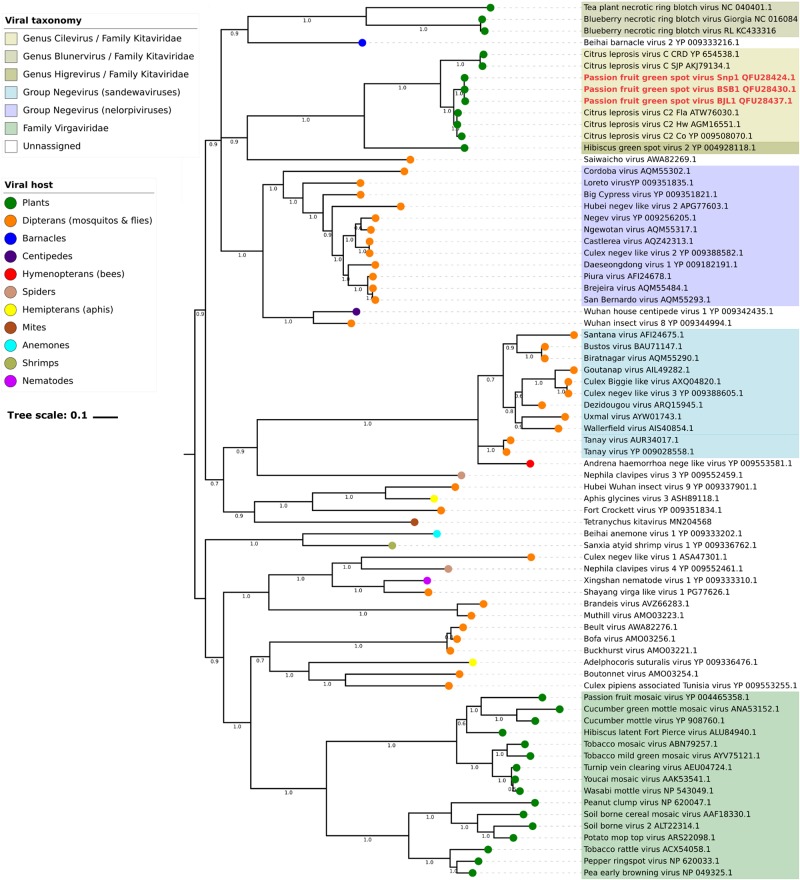
Molecular phylogenetic analysis of plant-infecting viruses of the family Kitaviridae. The midpoint-rooted Bayesian maximum clade credibility tree was inferred using a Markov Chain Monte Carlo (MCMC) of 6 million generations using the amino acid sequences of RNA dependent RNA polymerase (RdRp) of members of the family Kitaviridae (genera Cilevirus, Higrevirus, and Blunervirus), arthropod-infecting viruses, and viruses of the family Virgaviridae. Dataset included 443 positions and its evolutionary history was inferred based on the model LG + G + I + F (Le and Gascuel, 2008). Figures next to nodes indicate values of posterior probability branch support. Scale bar indicates the average number of amino acid substitutions per site. Passion fruit green spot virus sequences are highlighted in red.